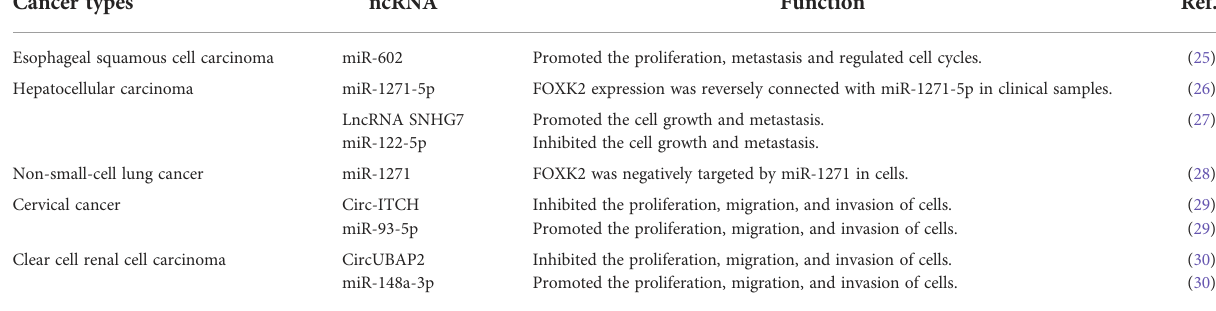
TABLE 1 ncRNAs targeting FOXK2 in